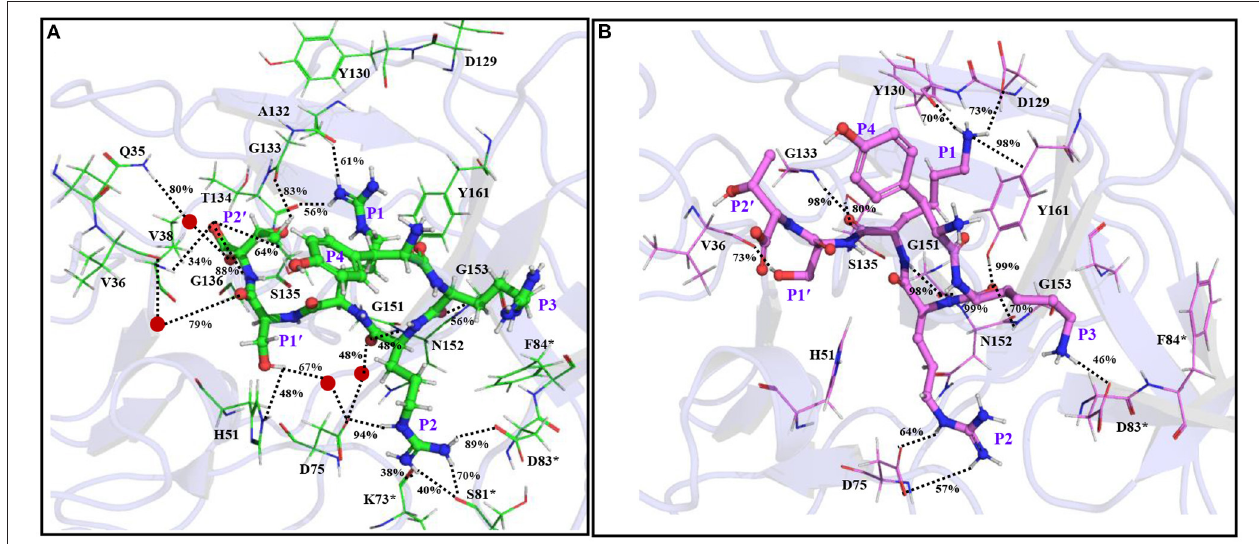
FIGURE 4 | The average simulated structures of the (A) YRRRST-protease (carbon atoms in green) and (B) YRKRST-protease (carbon atoms in violet) complexes. Different interactions are shown by dotted lines and their percentage occupations evolved during the simulations are also mentioned. Residues of NS2B are marked by *. The P1’–P4 residues of the inhibitors are